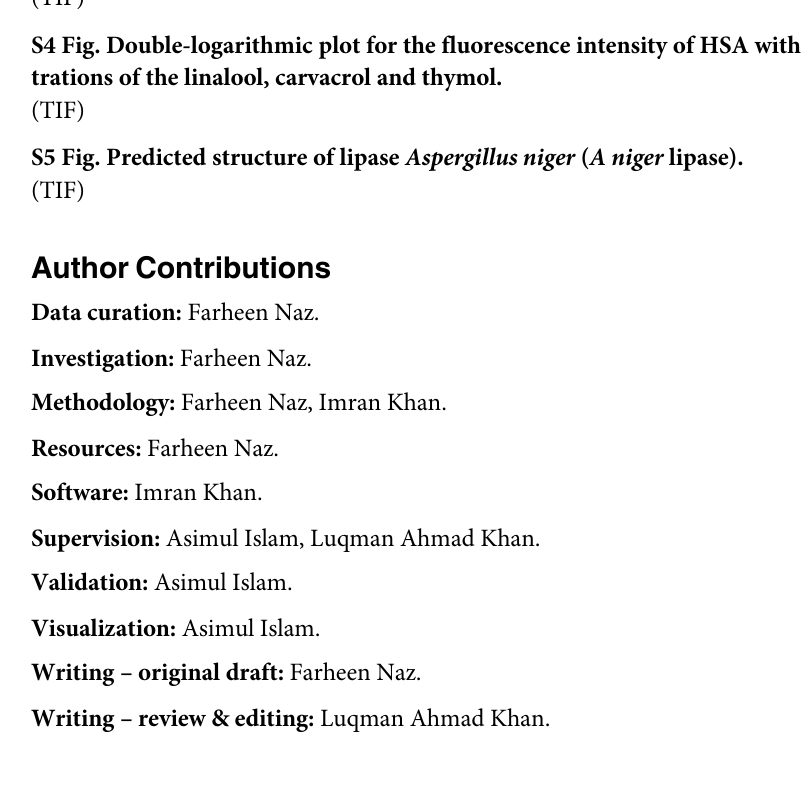
S1 Fig. Stern–Volmer plot (lipase–linalool, lipase–carvacrol and lipase–thymol). S2 Fig. Double-logarithmic plot for the fluorescence intensity of lipase with various con- centrations of the linalool, carvacrol and thymol. S3 Fig. Stern–Volmer plot (HSA-linalool, HSA-carvacrol and HSA-thymol). S4 Fig. Double-logarithmic plot for the fluorescence intensity of HSA with various concen- trations of the linalool, carvacrol and thymol. S5 Fig. Predicted structure of lipase Aspergillus niger ( A niger